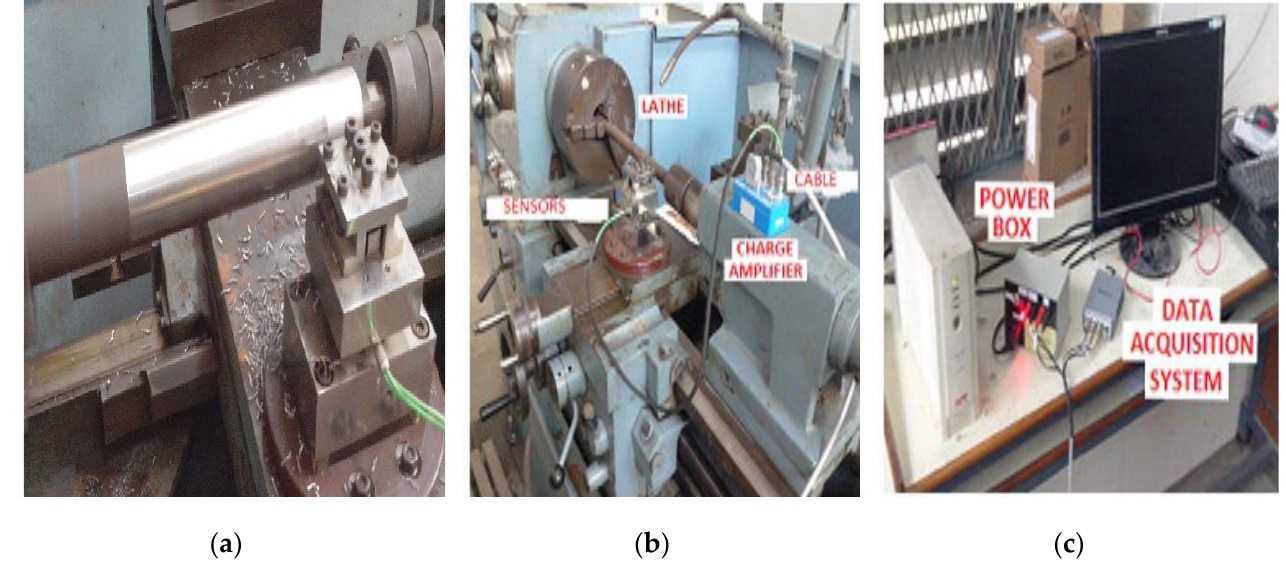
Figure 1. Experiment setup for wear analysis of tungsten carbide tool: ( a ) tool post, ( b ) different parts on the lathe, and ( c ) setup of the data-acquisition system.